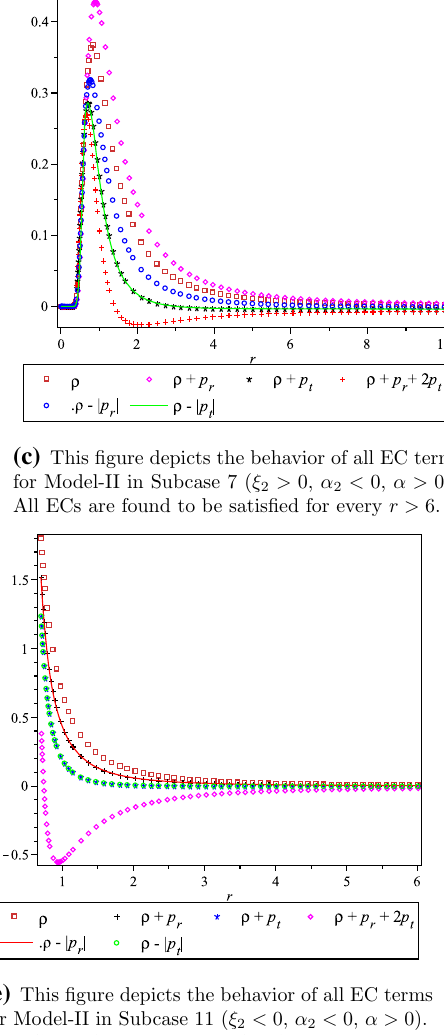
All ECs are found to be satisfied for every r > 4. Fig. 2 Plots of EC terms for 6 subcases of model II: ρ = α 2 Re ξ 2